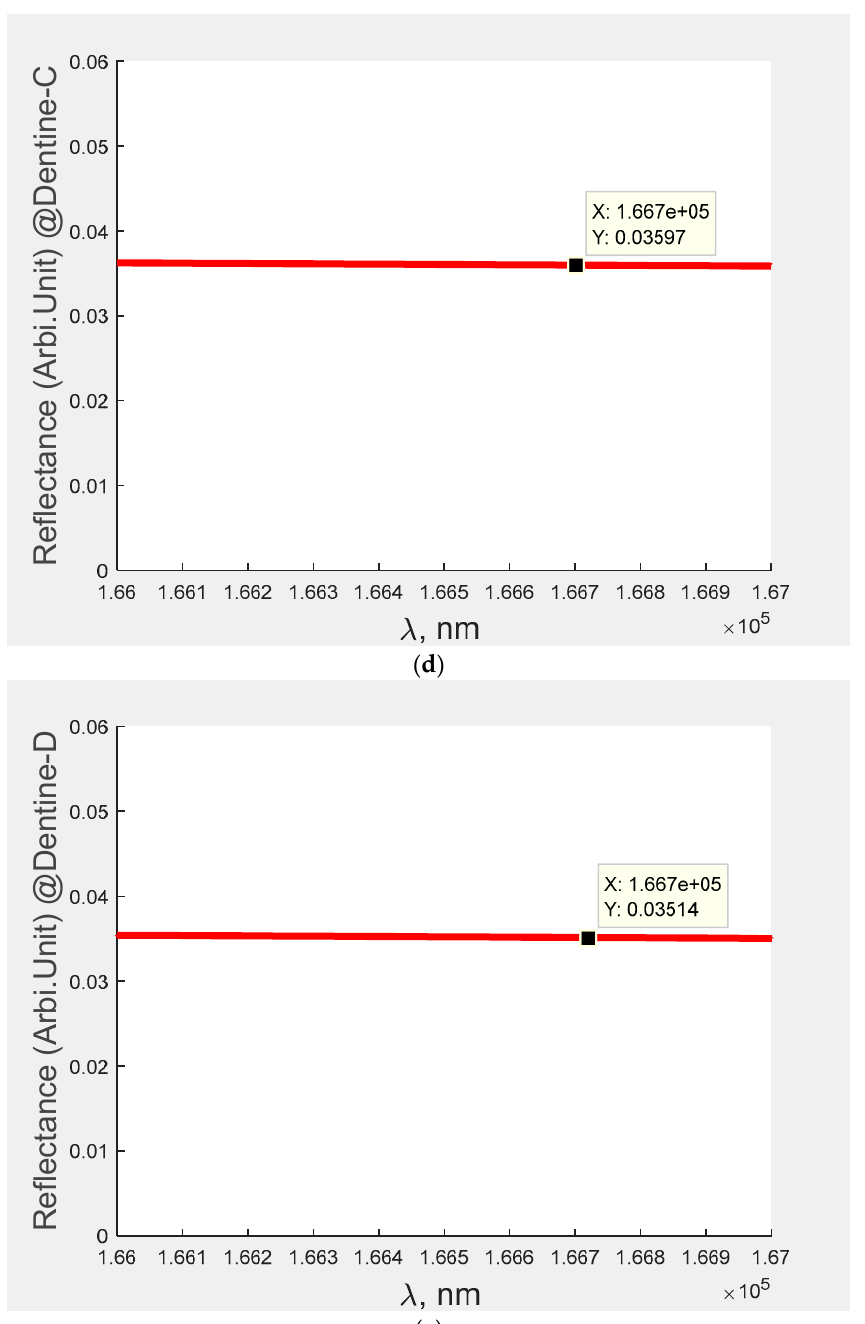
Figure 3. ( a ) Reflectance of dentine normal teeth at the signal 1.8 THz (frequency); ( b ) reflectance of dentine abnormal teeth (A) at the signal 1.8 THz (frequency); ( c ) reflectance of dentine abnormal teeth (B) at the signal 1.8 THz (frequency); ( d ) reflectance of enamel abnormal teeth (C) at the signal 1.8 THz (frequency); and ( e ) reflectance of enamel abnormal teeth (D) at the signal 1.8 THz (frequency).